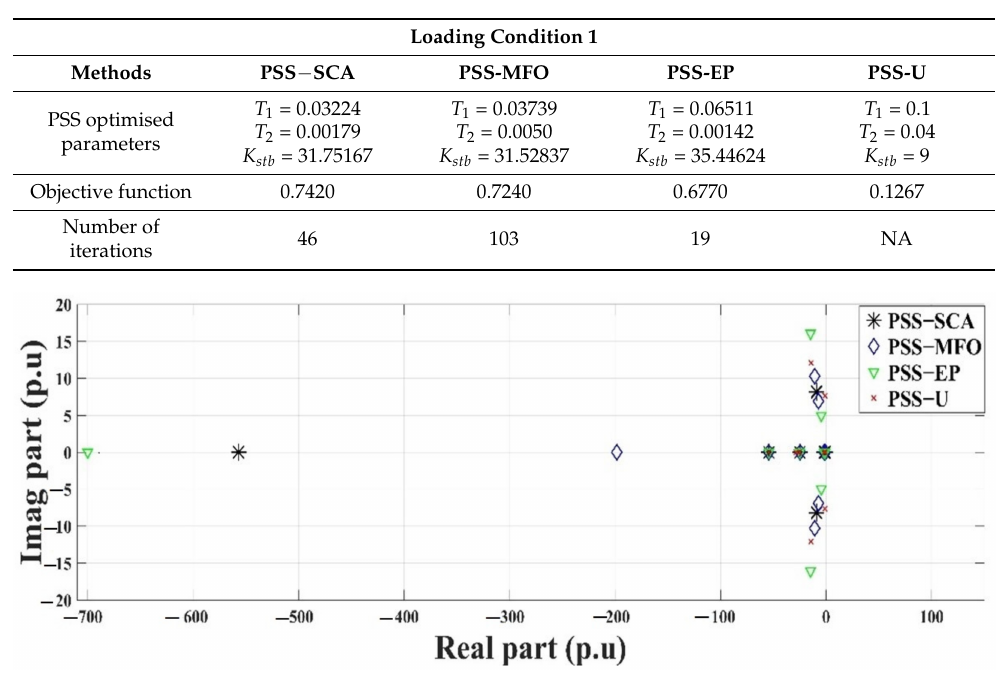
Table 7. Comparison of the PSS optimised parameters, eigenvalues and damping ratio for loading condition 1 of the SMIB.